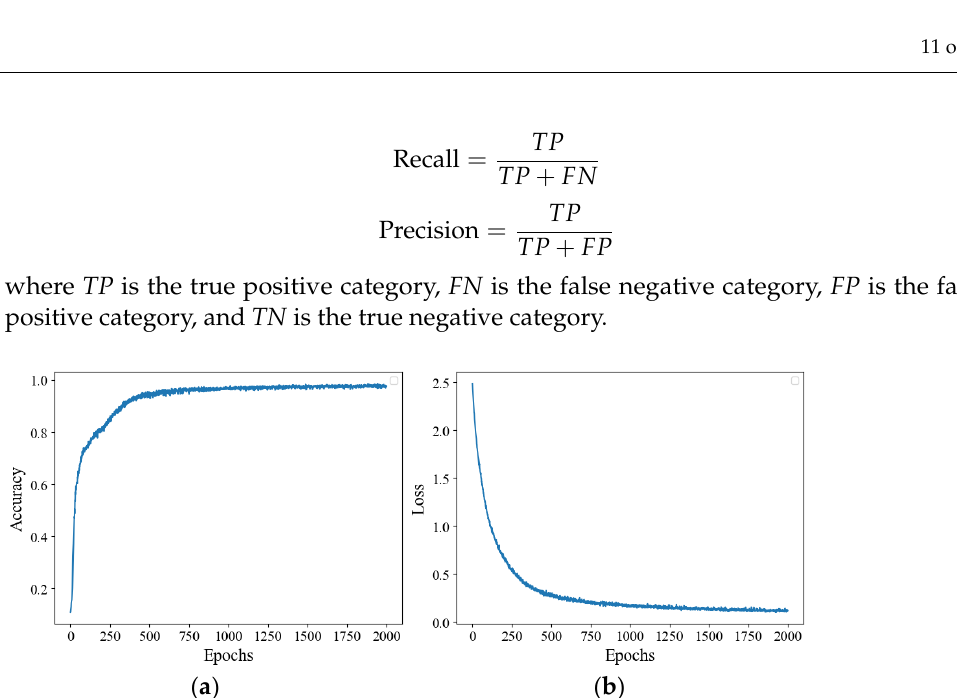
Figure 7. Training results of 2000 iterations. ( a ) Curve of accuracy – epochs; ( b ) Curve of loss –